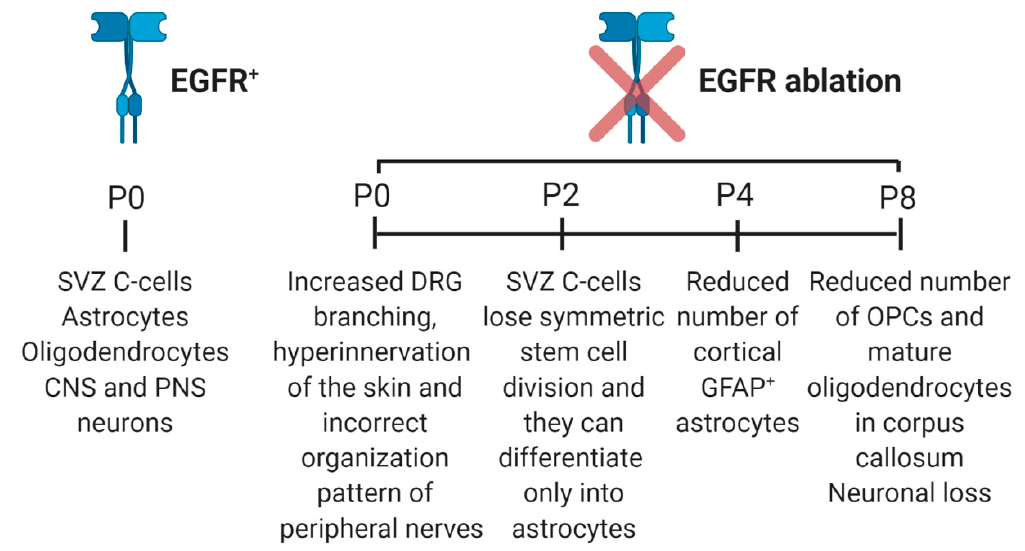
Figure 3. Diagram representing what happens to the nervous system cells after EGFR ablation. At P0, EGFR is widely expressed in the nervous system. EGFR deletion is detrimental for progenitors, astrocytes, oligodendrocytes and neurons. SVZ: subventricular zone; OPCs: oligodendrocyte precursor cells; PNS: peripheral nervous system; CNS: central nervous system; GFAP: glial fibrillary acid protein; DRG: dorsal root ganglia.